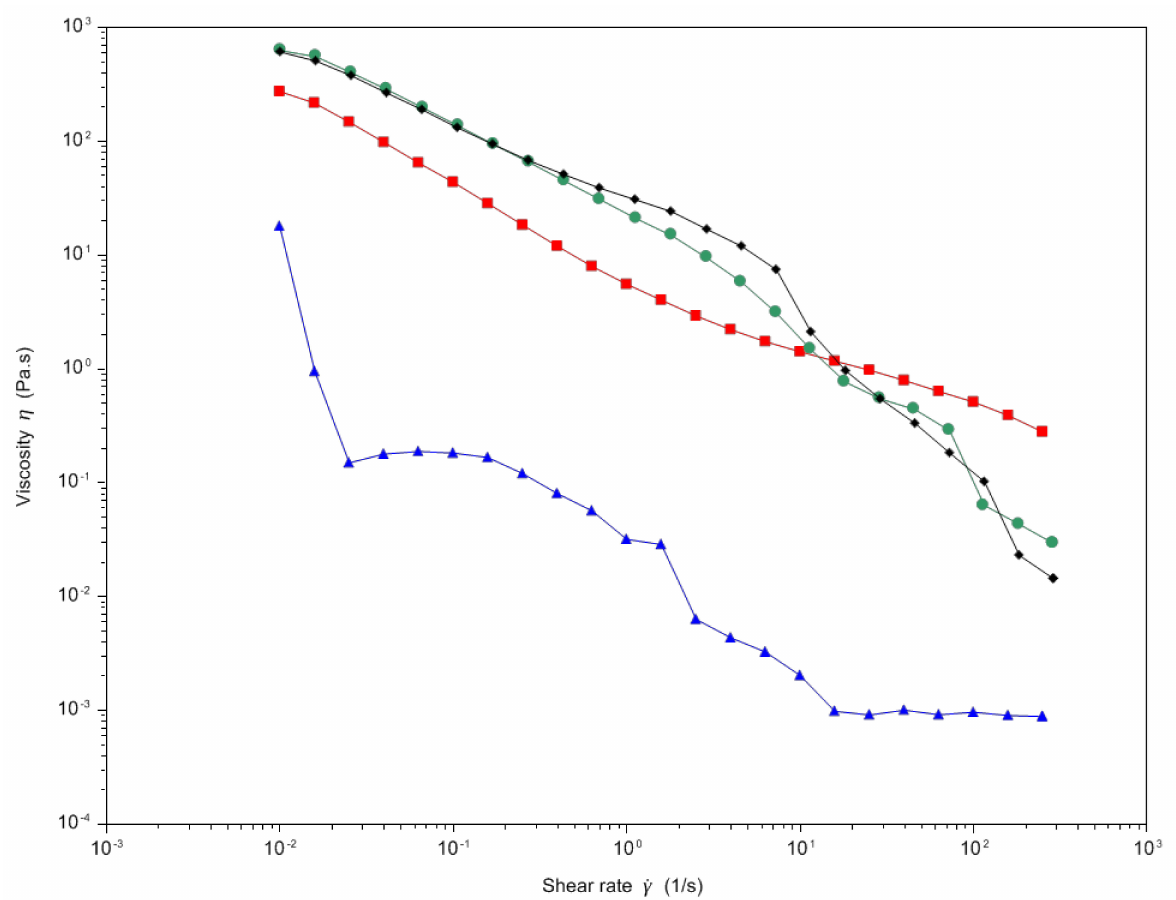
Figure 9. The viscosity curve of the swollen hydrogels obtained with HA(270)-FA-HEG-CL - 20 (green), HA(270)-FA-HEG-CL - 40 (black), HA(270)-FA-HEG-CL - 10 (red), and HA(8.7)-FA-HEG-CL - 20 (blue). Table 4. The major mechanical parameters of the hydrogels obtained with HA(270)-FA-HEG-CL - 10 ,